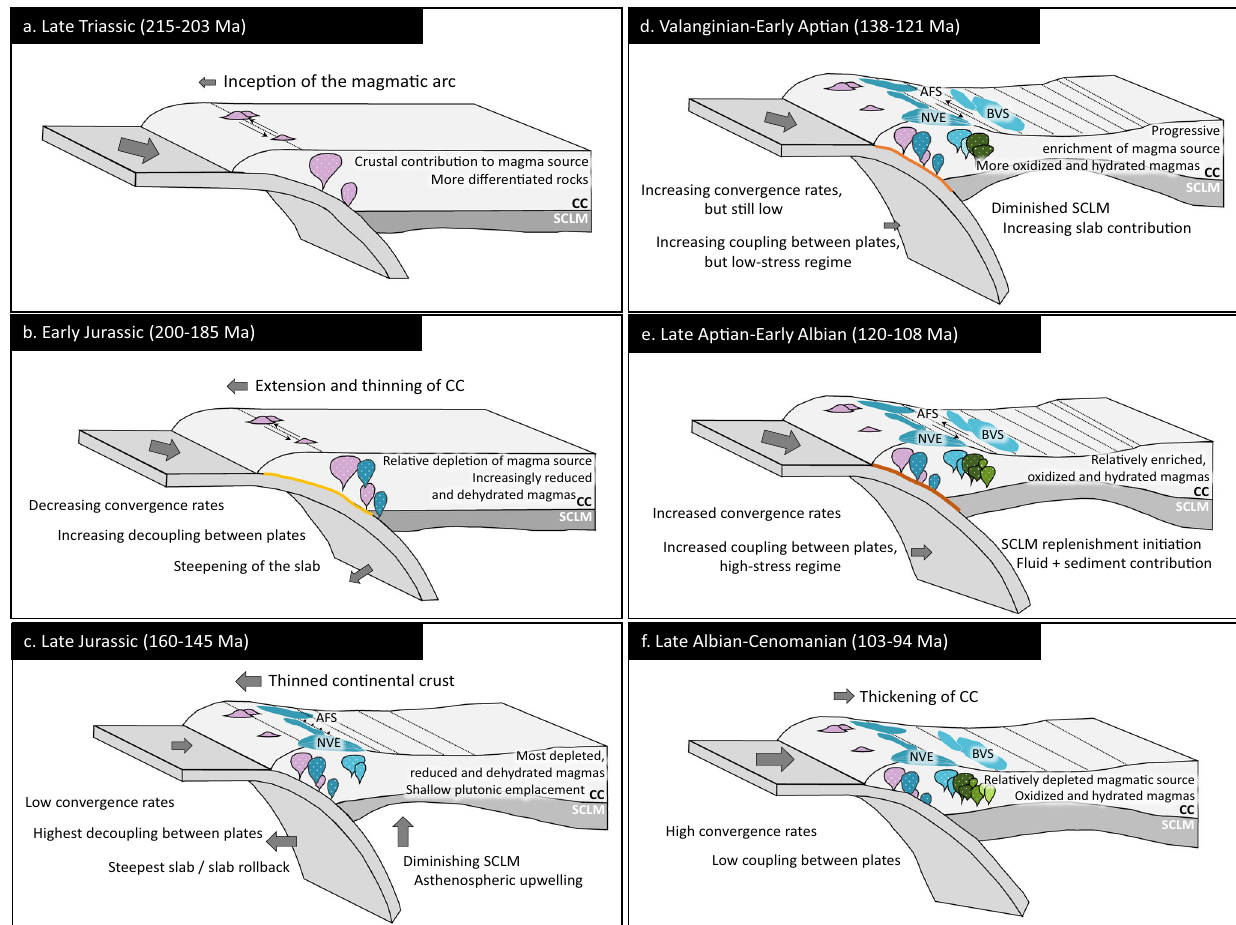
Fig. 4 Multistage evolution of the early Andean Cordillera. a Late Triassic plutonic episode (215 – 203 Ma): represents the inception of the early Andean magmatic arc in an attenuated continental arc, with crustal inputs to the magma source and the emplacement of granitic intrusions. b , c Early Jurassic to Late Jurassic plutonic episodes (200 – 145 Ma): this transtensional to extensional period implied a decrease in sediment, slab-derived fl uids and lithospheric mantle contributions to the magma source, decompressional melting and upwelling of asthenospheric material. This led to a progressively depleted, dehydrated and reduced magmatism during the Late Jurassic. d , e Valanginian to late Aptian plutonic episodes (138 – 108 Ma) showed the transition from an arc-normal extensional to a transtensional setting with probably higher convergence rates and increasing plate coupling. As a result, subduction contributions increased steadily over time, generating increasingly more enriched, hydrated and oxidized magmas. f Late Albian to Cenomanian plutonic episode (103 – 94 Ma) derived from moderately oxidized magmas and a relatively depleted mantle source related to high convergence rates and plate decoupling. CC, continental crust. SCLM, sub-continental lithospheric mantle. AFS, Atacama Fault System. NVE, La Negra volcanic event. BVS,